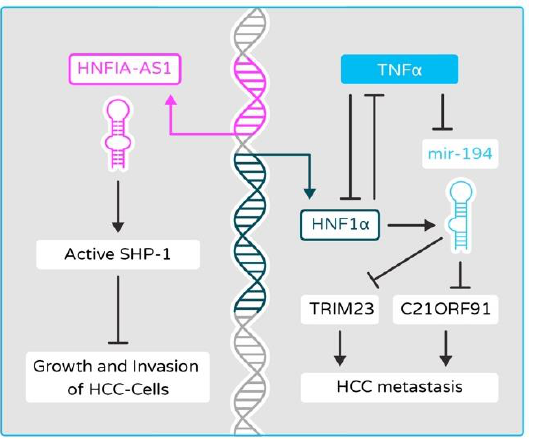
Figure 4. HNF1 α /HNF1A-AS1/miR-194 pathway in epithelial–mesenchymal transition (EMT) and hepatocellular carcinoma (HCC) metastasis. HNF1 α increases the activity of Src homology 2 domain-containing protein tyrosine phosphatase 1 (SHP-1) in human HCC cells via upregulating HNF1 α antisense RNA 1 (HNF1A-AS1) and inhibits hepatic carcinogenesis. HNF1 α induces the expression of miR-194, which inhibits the TNF α /NF-kB pathway and its downstream targets (tripartite motif containing 23, TRIM23, and Chromosome 21 Open Reading Frame 91, C21ORF91), and thus inhibits HCC metastasis. TNF α reciprocally inhibits the abundance of miR-194 by suppressing the expression of HNF1 α in HCC cells and induces the expression of TRIM23 and C21ORF91, which play a role in HCC